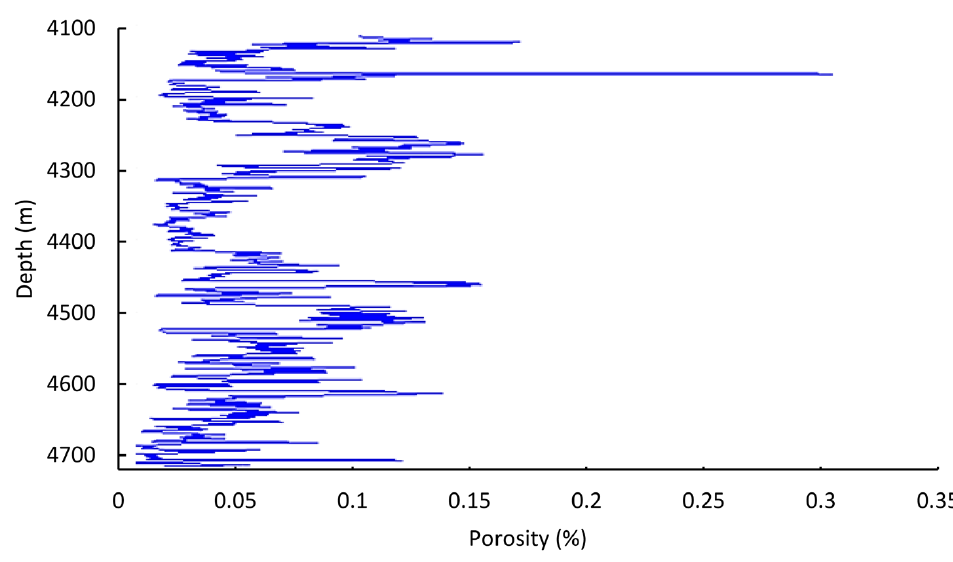
Figure 2. Variations of porosity (%) vs. the depth (m) of wellbore-D in the Azar oilfield.